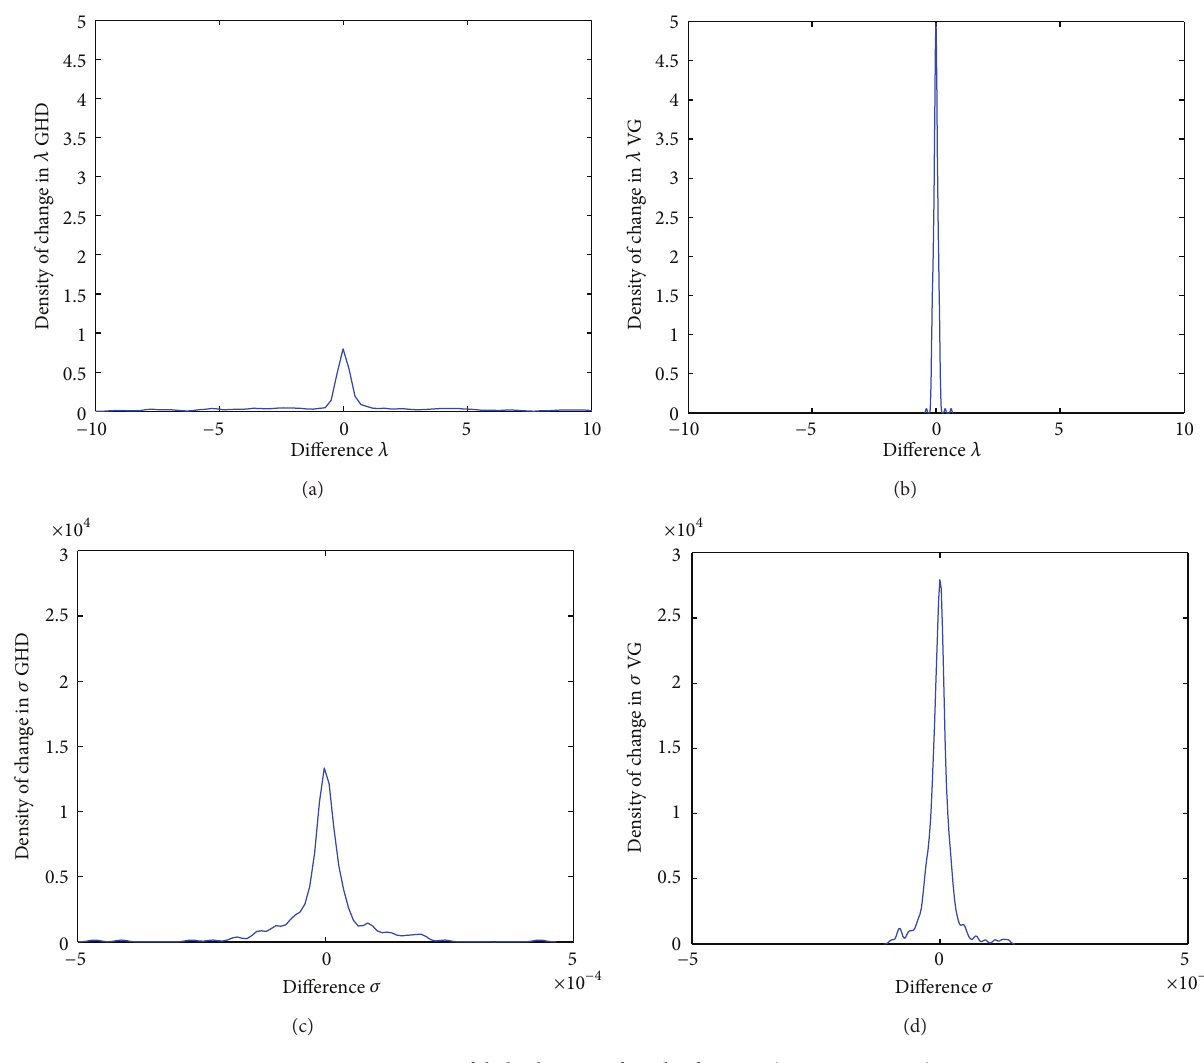
Figure 4: Density of daily change in 𝜆 and 𝜎 for AGL (GHD versus